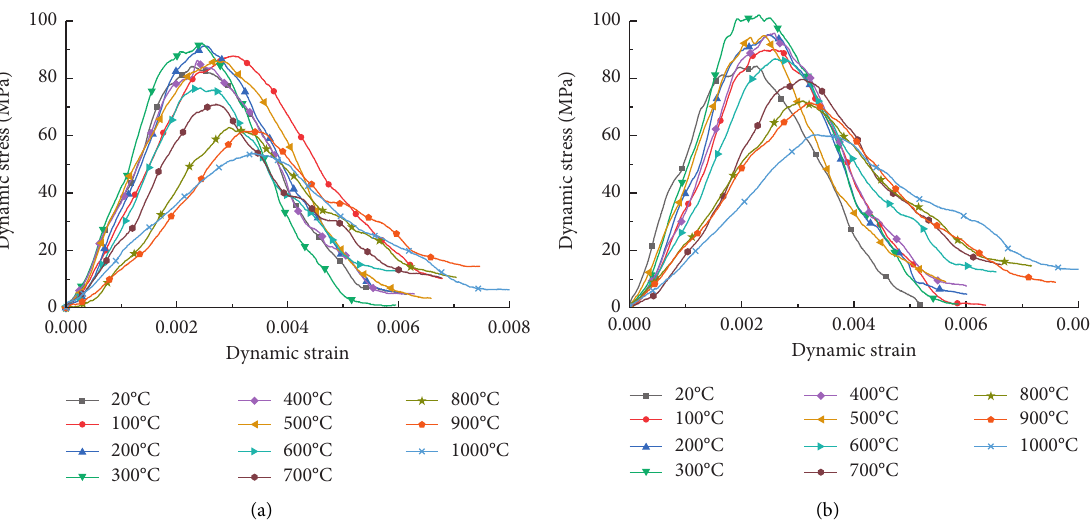
Figure 7: Dynamic stress-strain curves of high temperature sandstone after two cooling methods: (a) water cooling; (b) natural cooling.